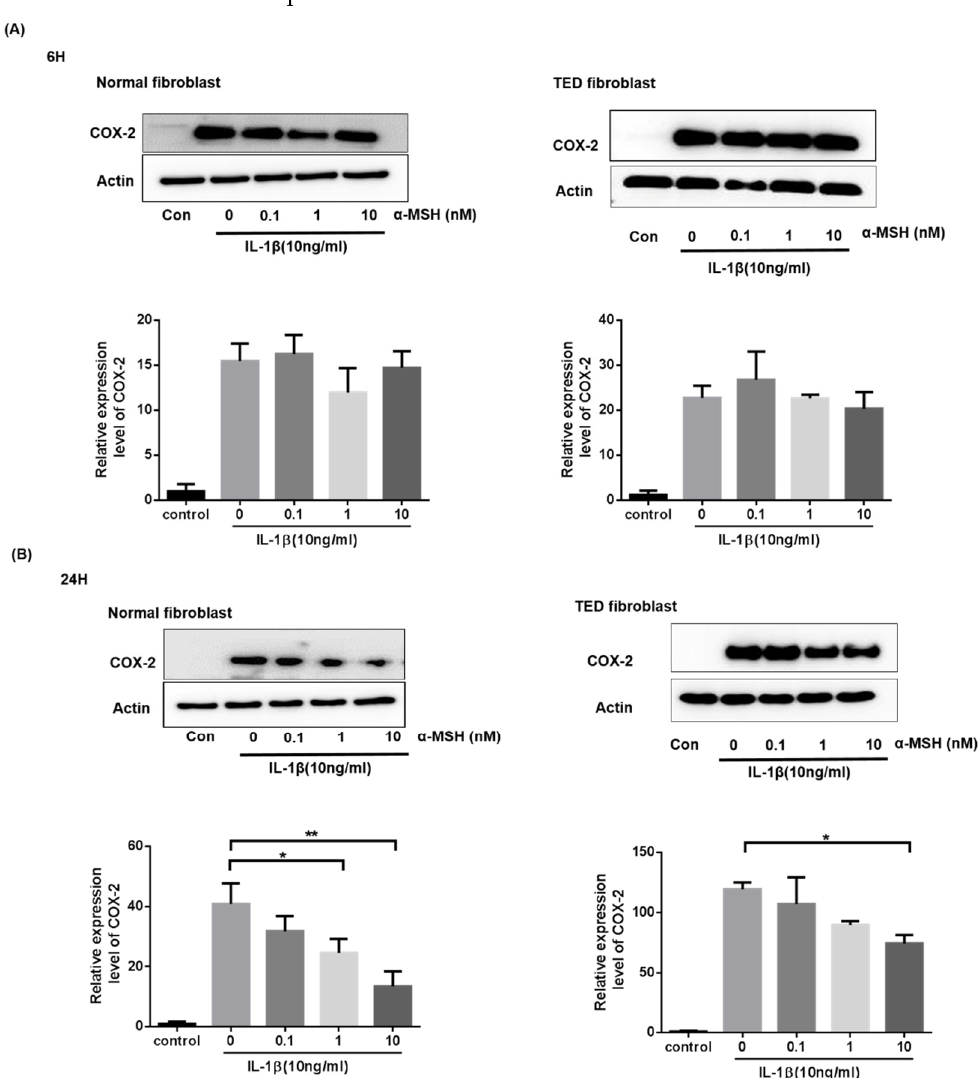
Figure 4. Effect of α -MSH on IL-1 β -induced expression of COX-2 proteins in normal and TED orbital fibroblasts. α -MSH suppressed the expression of IL-1 β -induced COX-2 in orbital fibroblasts. Orbital fibroblasts cells were stimulated with IL-1 β (10 ng/mL), and α -MSH (0–10nM) for 6 ( A ) and 24 h ( B ). COX-2 expression was assayed by western blot analysis. The graph shows representative data expressed as mean ± standard error for the mean of three independent experiments. * p <0.05, ** p <0.01 compared to cells without α -MSH.